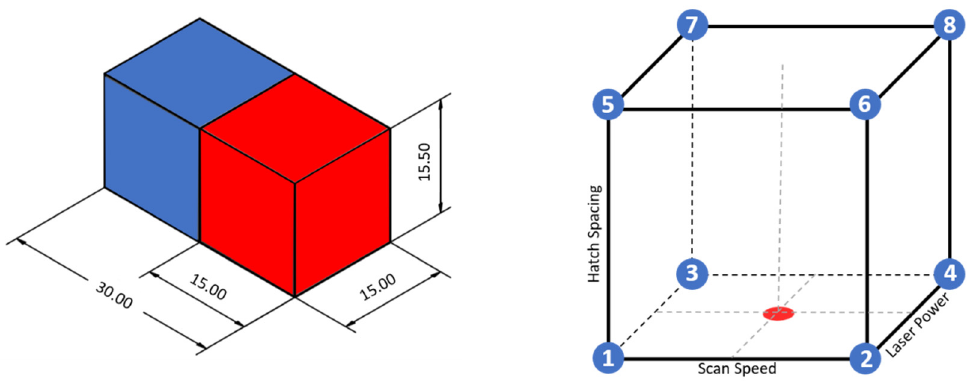
Figure 2. Test structure and respective CCD (all dimensions are in mm).